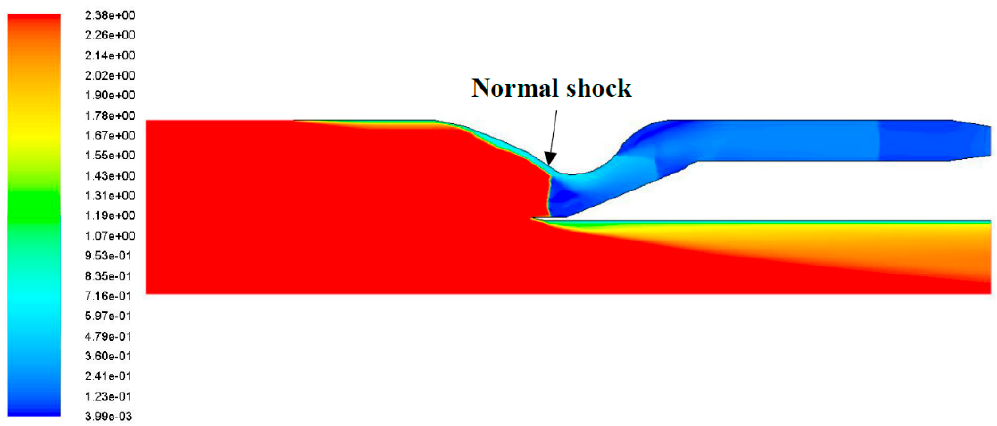
Figure 36. Mach contour of the over-under turbojet-scramjet hybrid engine in turbojet mode.